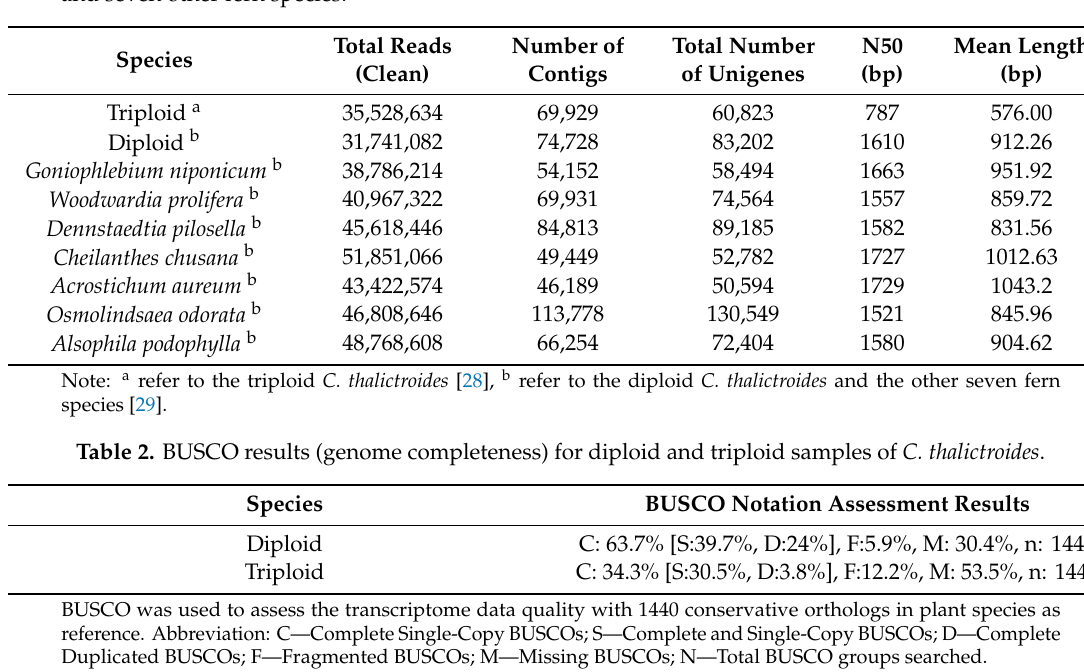
Table 1. A summary of the sequencing and assembly for diploid and triploid samples of C. thalictroides and seven other fern species.